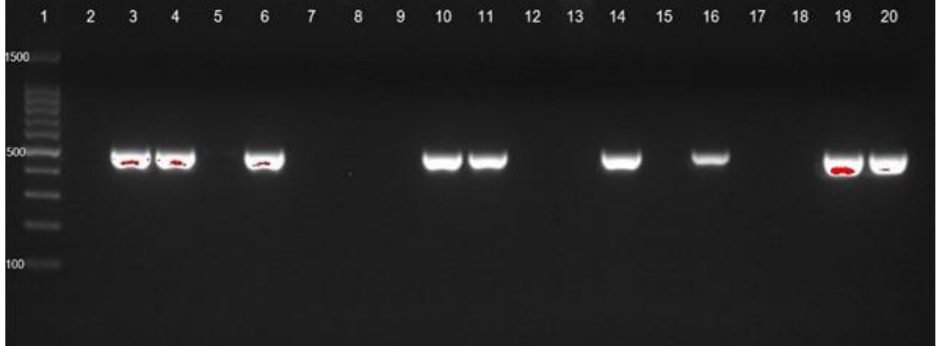
Figure 1. blaOXA-23 gene identification of CRAb-cc isolates from Prof. Dr. R. D. Kandou Hospital, Manado. Lane 1 = DNA ladder; lane 2 = negative control; lane 3 = positive control; blaOXA-23 was detected in lanes 4 (MDO-1), 6 (MDO-3), 10 (MDO-7), 11 (MDO-8), 14 (MDO-11), 16 (MDO-13), 19 (MDO-16), and 20 (MDO-17). Other isolates were negative for blaOXA-23 . MDO =